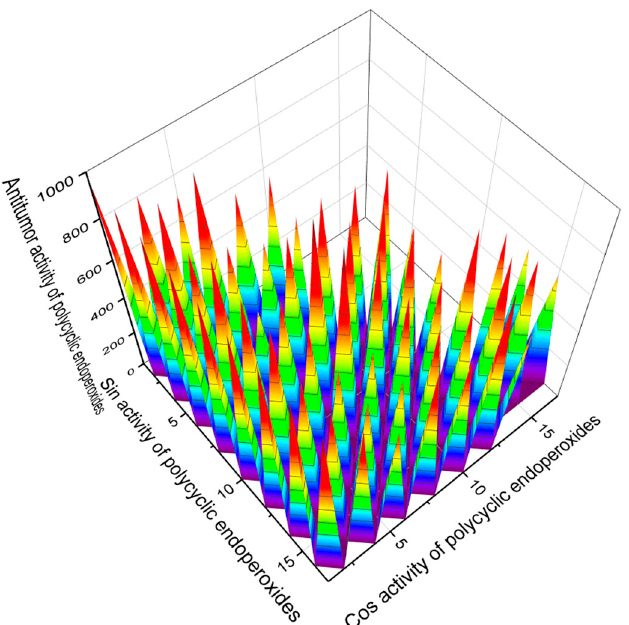
Figure 14. The 3D graph shows the predicted and calculated antitumor activity of selected polycyclic endoperoxides (compound numbers: 11 , 17 , 30 , 33 , 142 , 143 , 164 , and 165 ) showing the highest degree of confidence, more than 95%. These polycyclic endoperoxides can be used in clinical medicine as agents with strong antitumor activity.